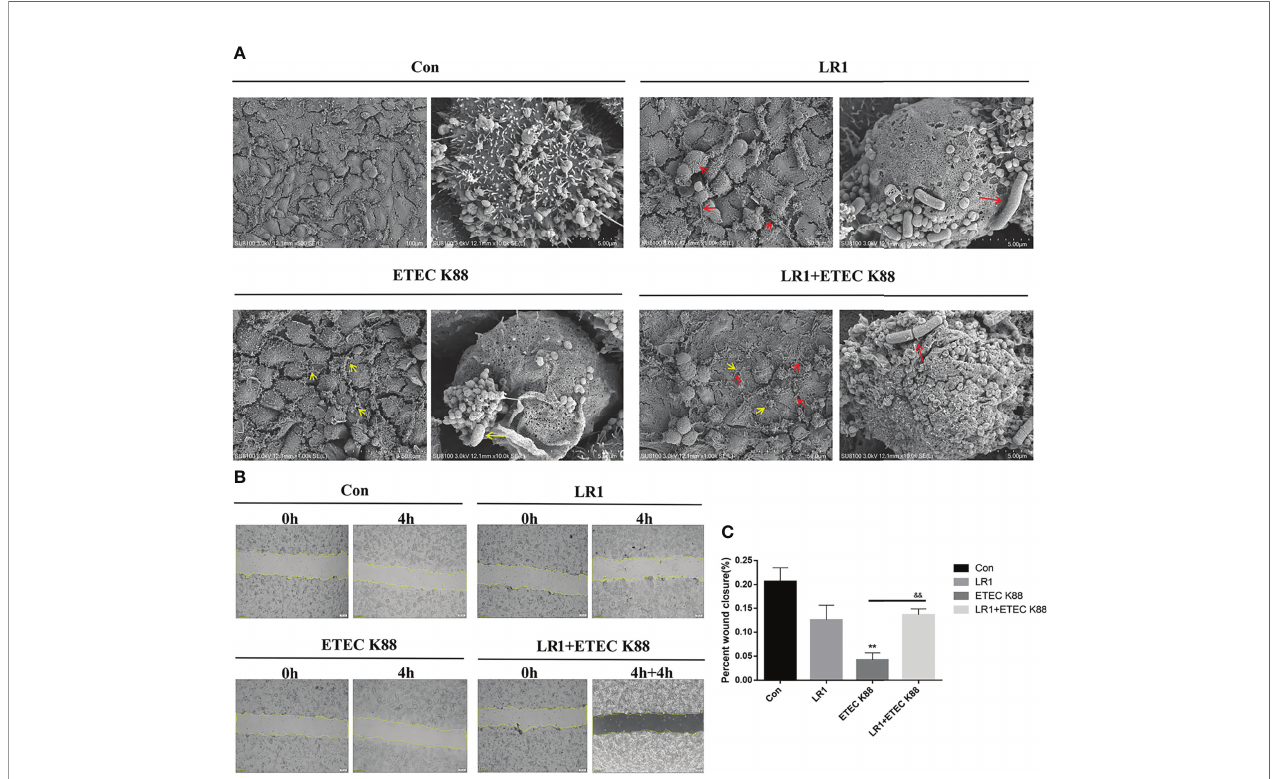
FIGURE 3 | Effects of L. reuteri LR1 on cell adherence and wound healing in IPEC-J2 cells treated with ETEC K88. (A) The scanning electron microscope (SEM) of IEPC-J2 cells pretreated with L. reuteri LR1 (1 × 10 9 cfu/ml) for 4 h followed by ETEC K88 (1 × 10 8 cfu/ml) challenged for 4 h. (B) L. reuteri LR1 promotes cell motility as shown by in vitro scratch assays in IPEC-J2 cells challenged with ETEC K88. Live-cell images were taken right after the “ scratches ” were created (0 h) and at 8 h post-treatment (or not) of L. reuteri LR1 (1 × 10 9 cfu/ml) and ETEC K88 (1 × 10 8 cfu/ml). (C) Quanti fi cation of percent wound closure was performed by detecting the decline in the denuded area at 8 h. Cells were treated with L. reuteri LR1 (1 × 10 9 cfu/ml) for 4 h, and then followed by ETEC K88 (1 × 10 8 cfu/ml) for 4 h. Data presented as mean ± SEM ( n = 3). ** p < 0.01 vs. the control group, && p < 0.01 vs. the ETEC K88 group. Red arrows in “ LR1 and LR1+ETEC K88 ” represent Lactobacillus reuteri 1 (LR1), and yellow arrows in “ ETEC K88 and LR1+ETEC K88 ” represent E. coli (ETEC